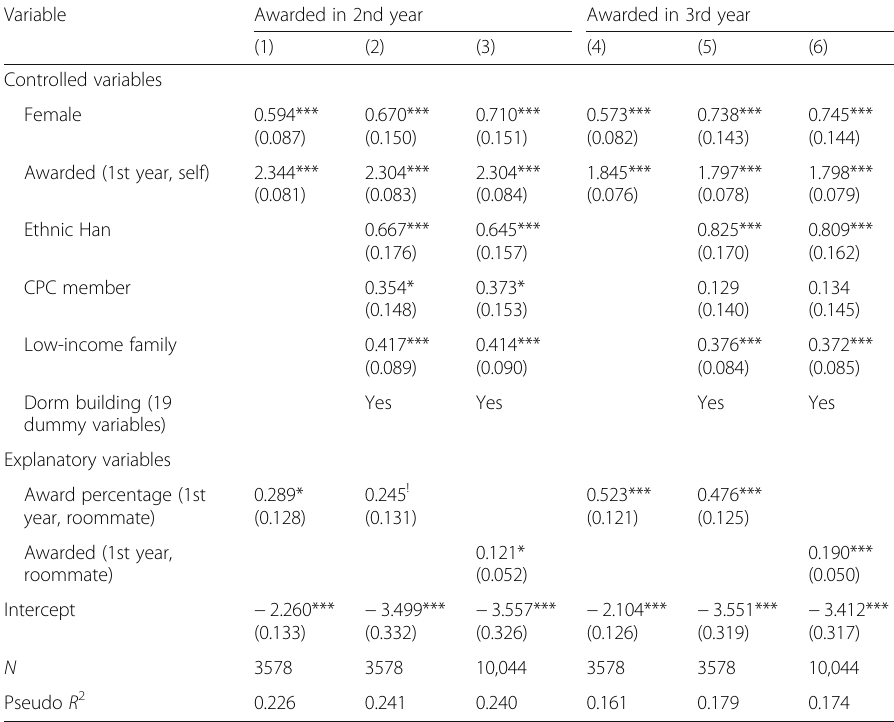
Table 2 Peer social capital effect on academic achievement and time trend